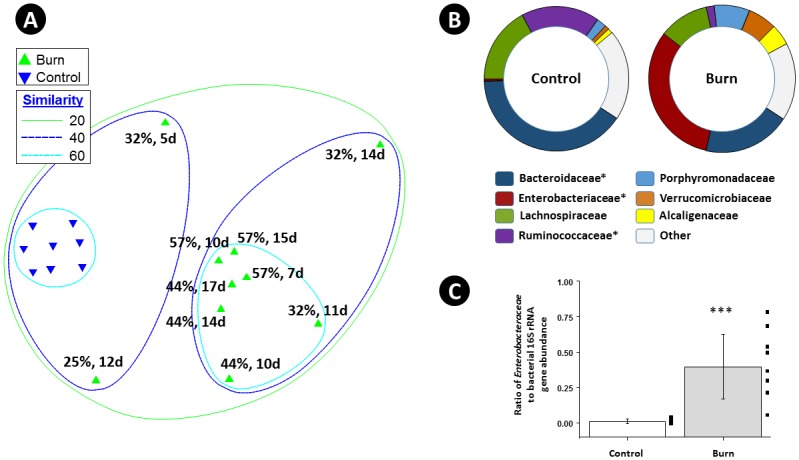
Effects of Burn Injury on Human Gut Microbiome.The non-metric multidimensional scaling (NMDS) plot (A) demonstrates the effect of burn injury on the overall human fecal microbial community structure, as assessed by bacterial ribosomal RNA gene amplicon sequencing. The NMDS plot is based on sample-standardized and log transformed abundance data. The NMDS plot and the hierarchical cluster overlay are based on a resemblance matrix calculated using Bray-Curtis similarity. The 2D stress value was 0.10. Fecal samples were taken from eight control patients and from four burn injury patients and analyzed at different time points (days after injury), as indicated in the figure. The most abundant bacterial families in control patients and burn patients are indicated in pie charts (B), and taxa which were significantly different by Kruskal-Wallis one-way analysis of variance (*,FDR-P <0.05). A box-plot of the distribution of the ratio of rRNA genes from Enterobacteraceae to total bacterial rRNA genes in control and burn patients measured by qPCR is shown (C), and the ratio of each individual is shown adjacent to the box-plot. A statistically significant effect of burn injury was observed (two-tailed t-test ***, p< 0.0001).